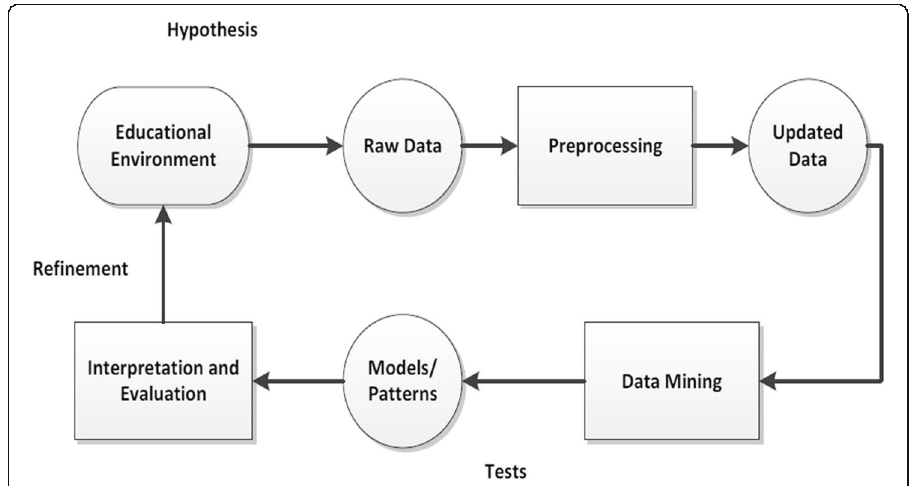
Fig. 2 Knowledge discovery process in educational institutions (Moscoso-Zea, Andres-Sampedro, & Lujan-Mora,